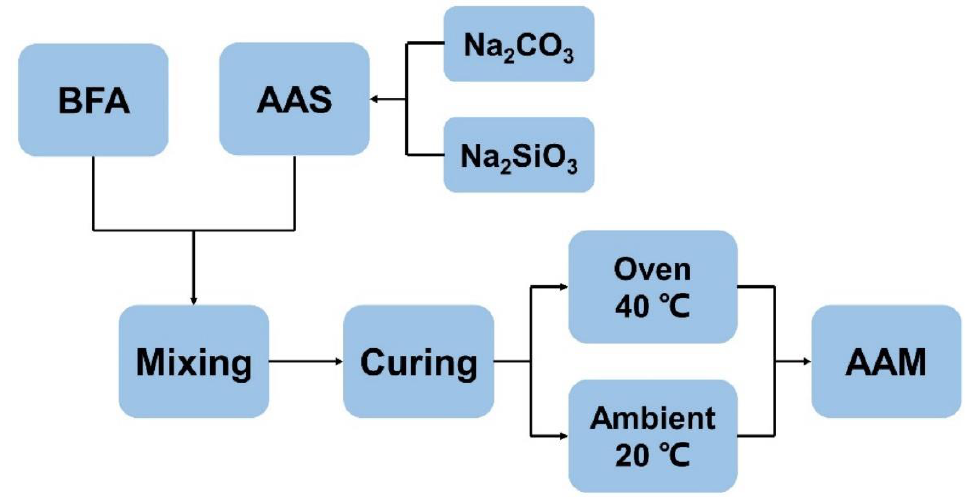
Figure 4. Schematic of BFA-based AAM paste preparation.